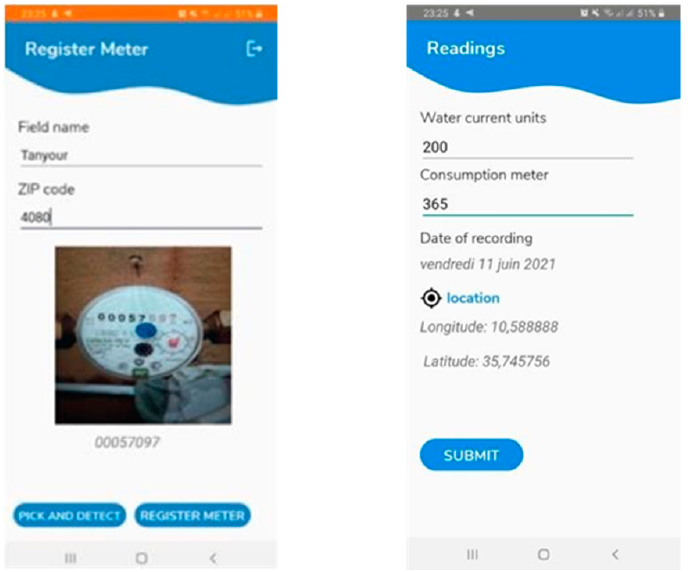
Figure 15. The Online detection interfaces.